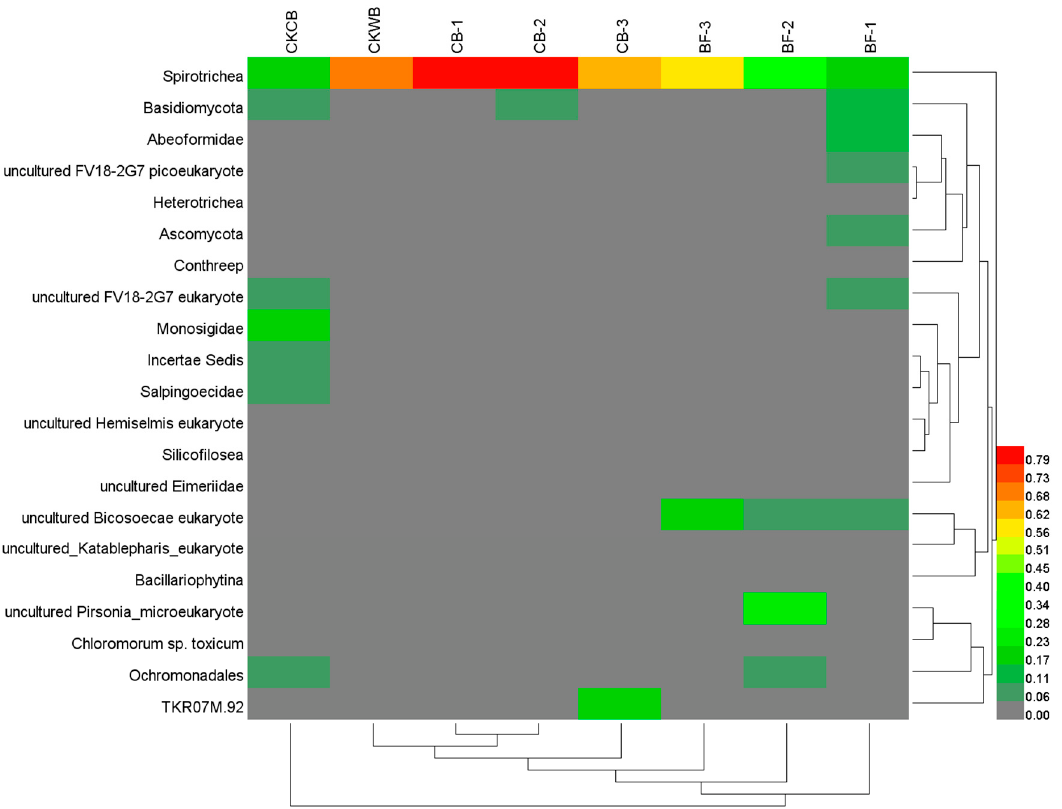
Figure 8. Heatmap diagram for the dominant eukaryote genera.